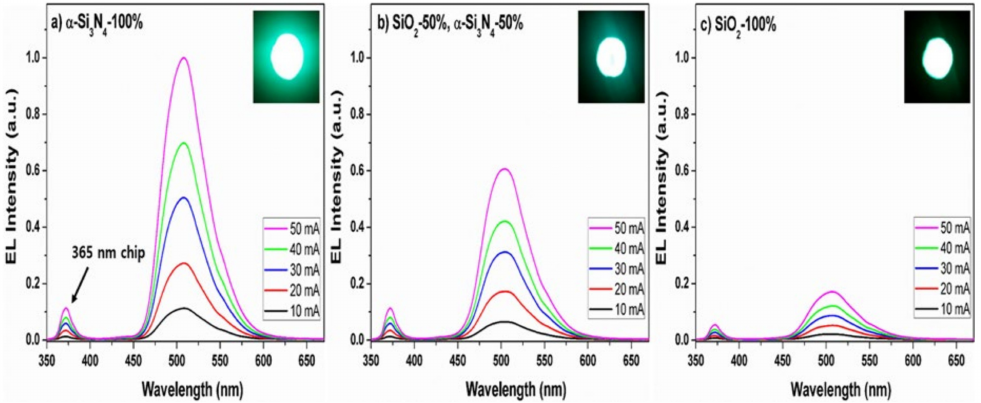
Figure 14. LED-PL spectra of NUV LEDs combined with of BSON:Eu 2 + phosphor synthesized using α -Si α -Si 3 N 4 –100% ( a ), SiO 2 –50% and 3 N 4 -50% ( b ), SiO 2 –100% ( c ) monitored as a function of applied forward bias